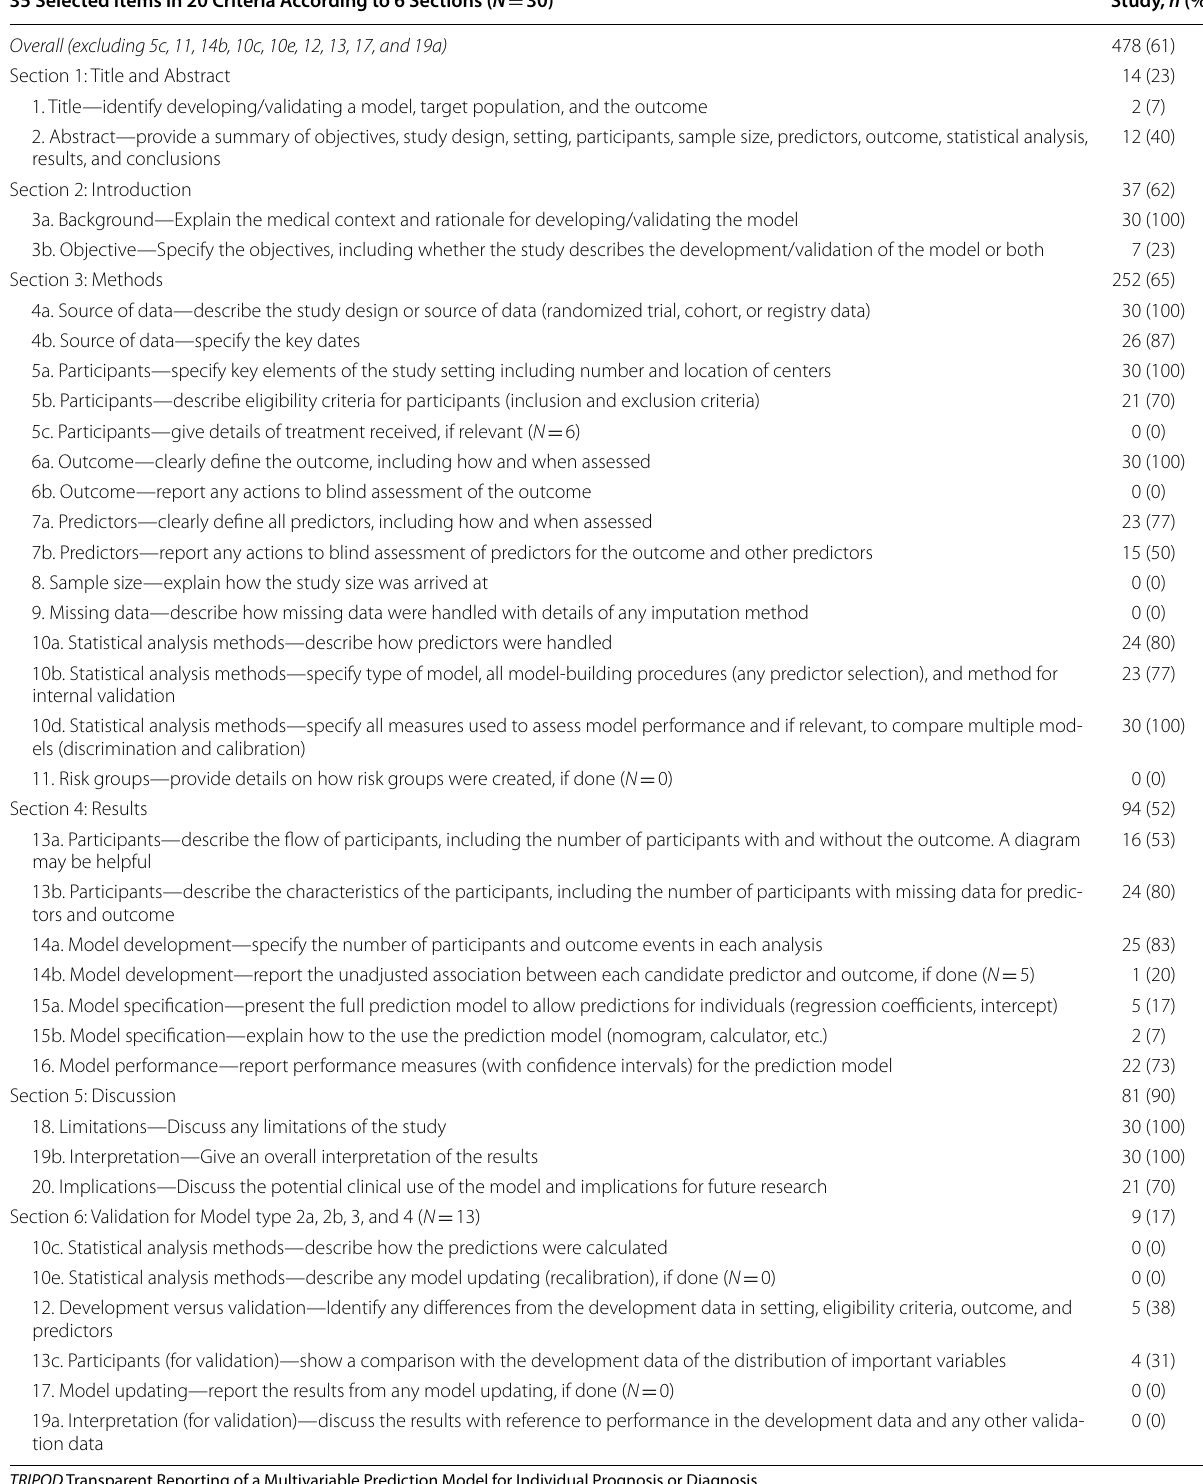
TRIPOD Transparent Reporting of a Multivariable Prediction Model for Individual Prognosis or